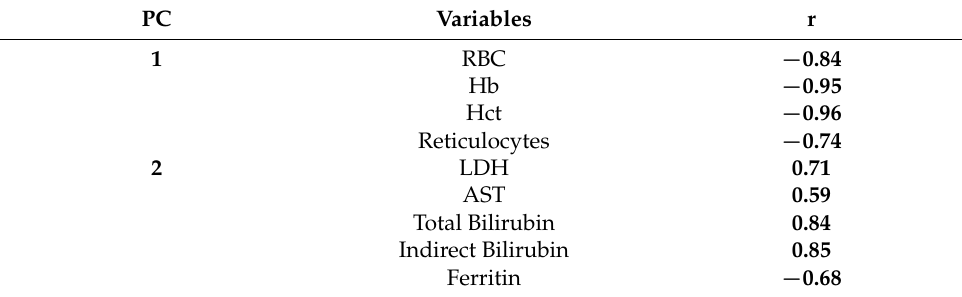
Table 4. Laboratory parameters associated with SLU determined by PCA.